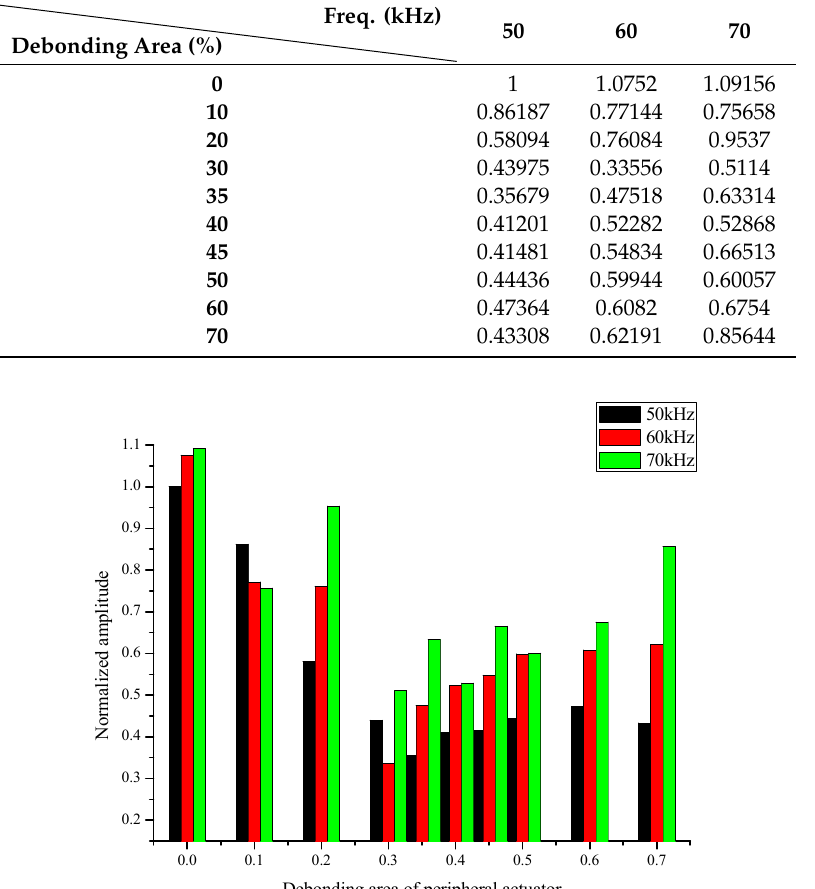
Figure 17. The variation of normalized amplitude of the signal when the excitation frequencies is 50 kHz, 60 kHz and 70 kHz.